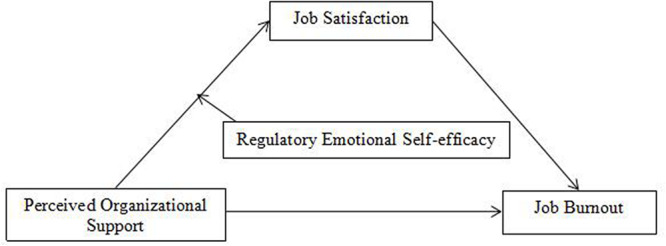
Hypothesized model.